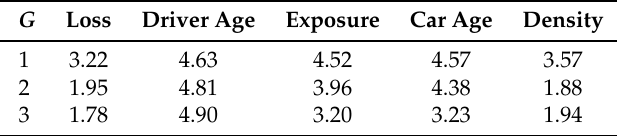
Table 3. Mean of the Ordinal Variables by Cluster ( G = 3).